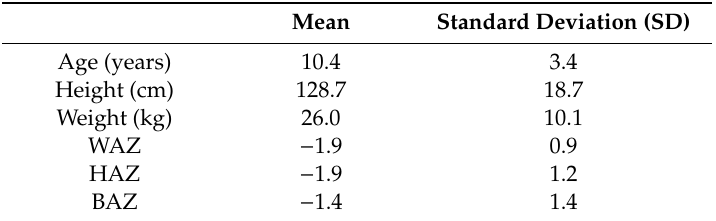
Table 1. Characteristics of the sample. Mean and standard deviation of age, height, weight, and growth-related